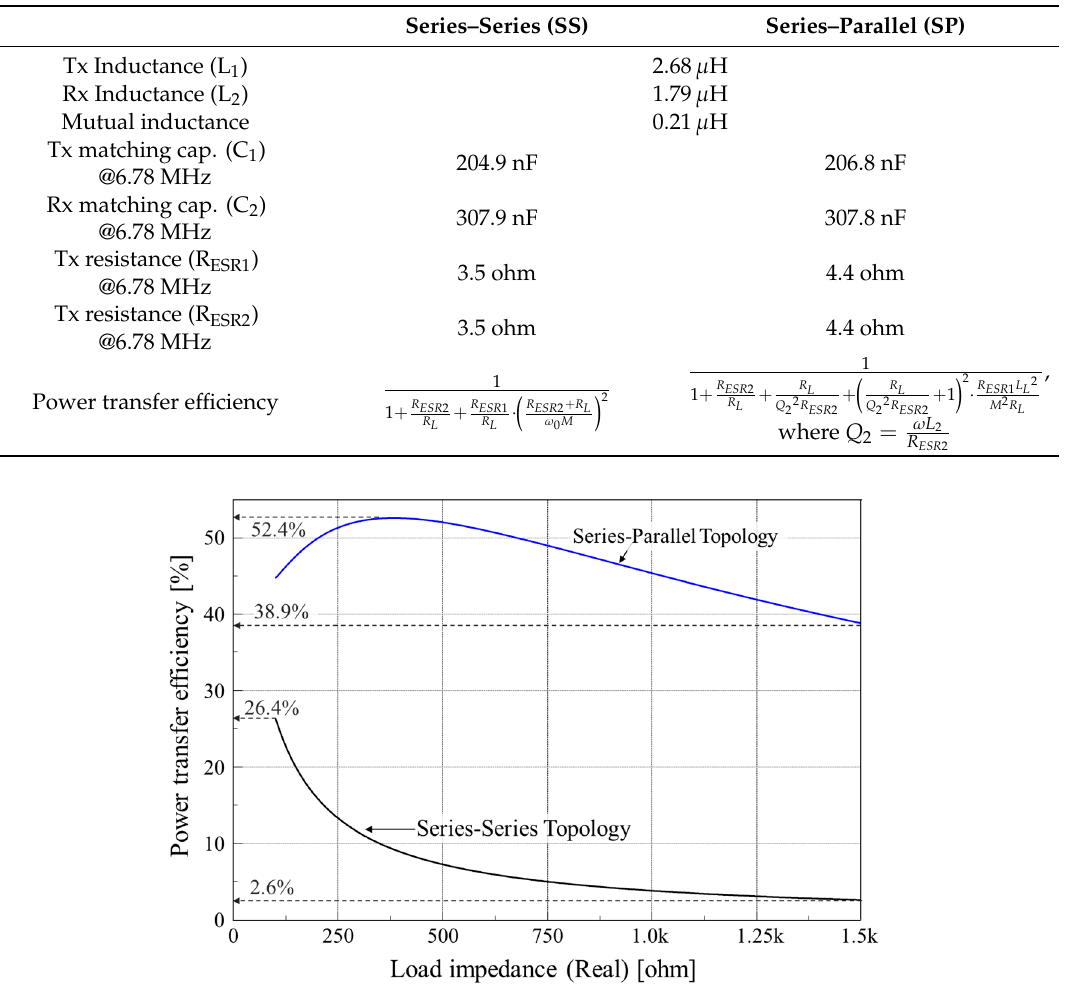
ffi ciency depending on changes in load Figure 6. Variation in power transfer efficiency depending on changes in load impedance. Figure 6. Variation in power transfer e